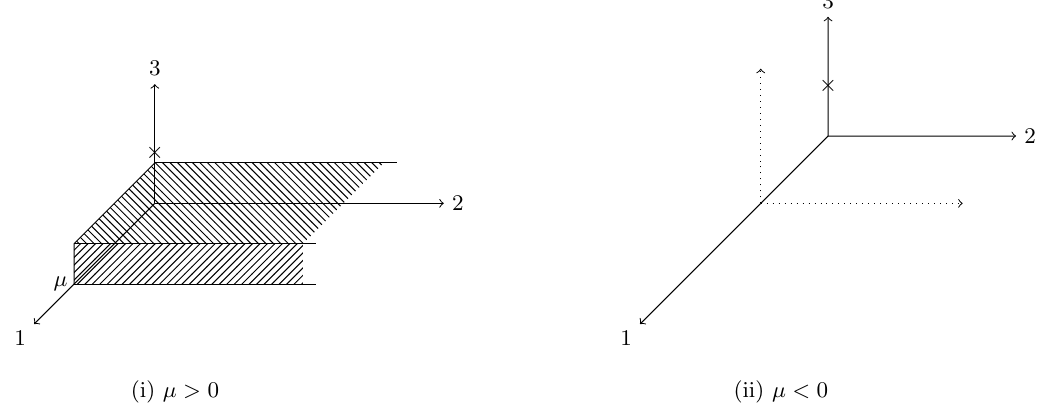
Figure 7 . The left (cid:12)gure shows (cid:22) > 0 case where asymptotic Young diagram ( (cid:22) ) is imposed. The right one shows (cid:22) < 0 case where the origin is shifted to the x 1 direction by (cid:22) . The crosses mean